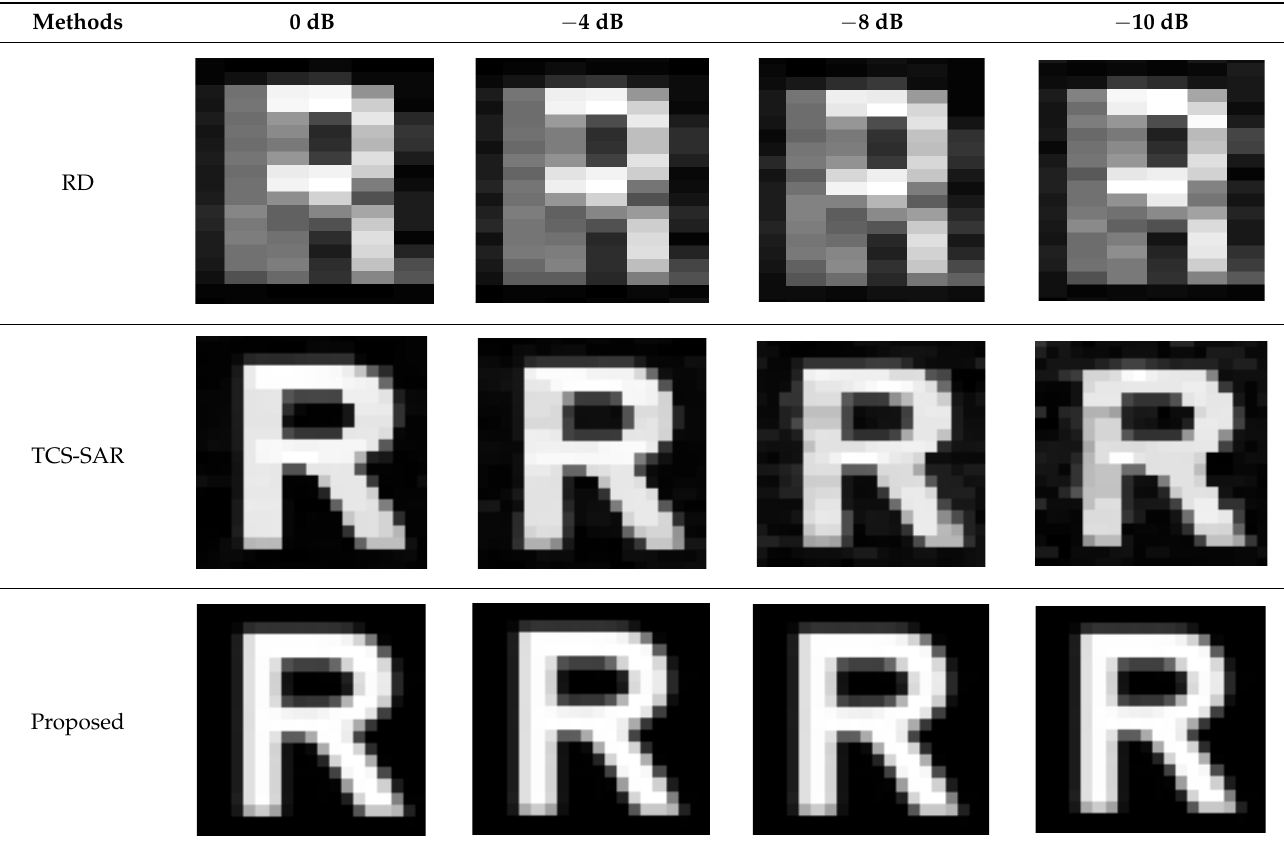
Table 2. Comparison of the imaging results for different SNRs of − 0 dB, − 4 dB, − 8 dB and − 10 dB.